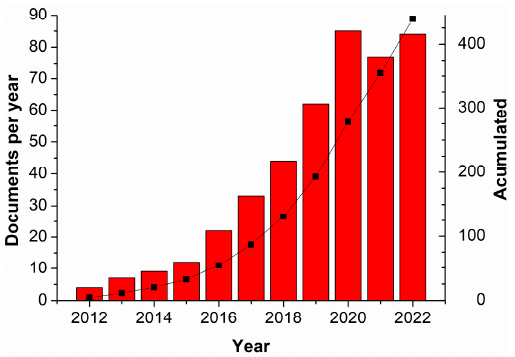
Figure 14. Year-wise publication of documents in CSAM field.